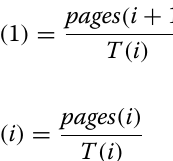
Algorithm 1 Parallel migration process